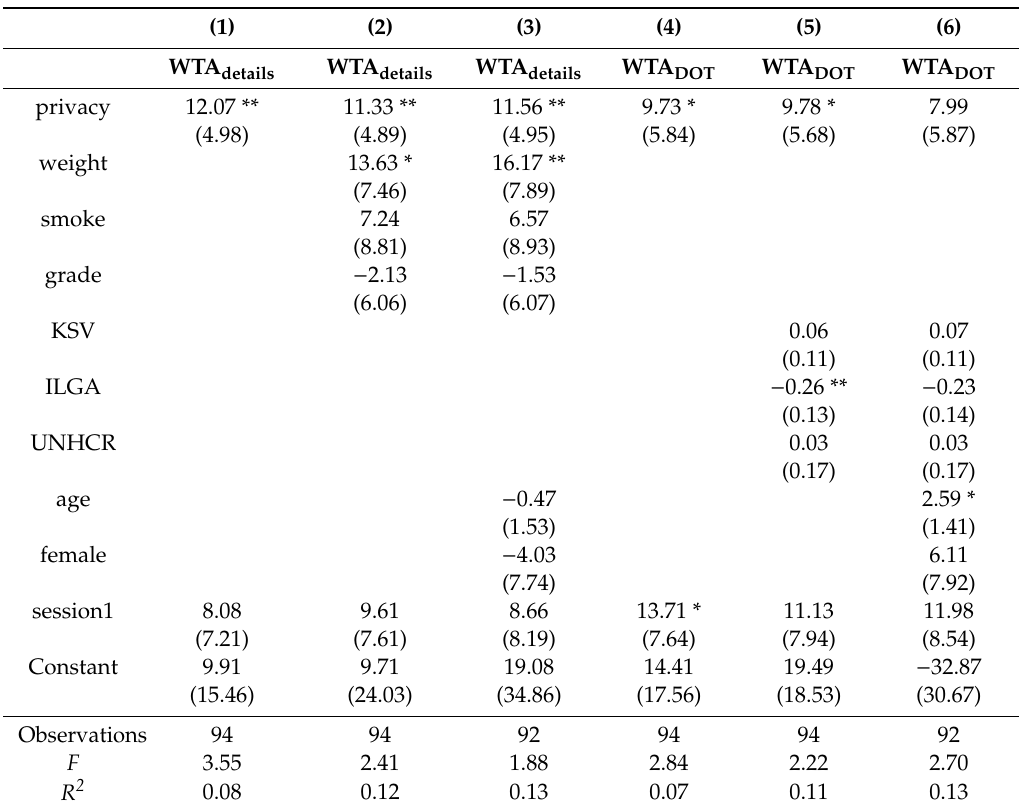
Table 2. OLS regressions of WTA on self-stated privacy behavior (additive index of a1–a5) and information at